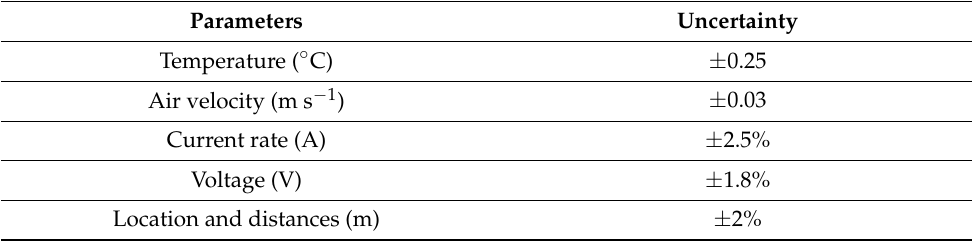
Table 2. Uncertainties on the measured values.